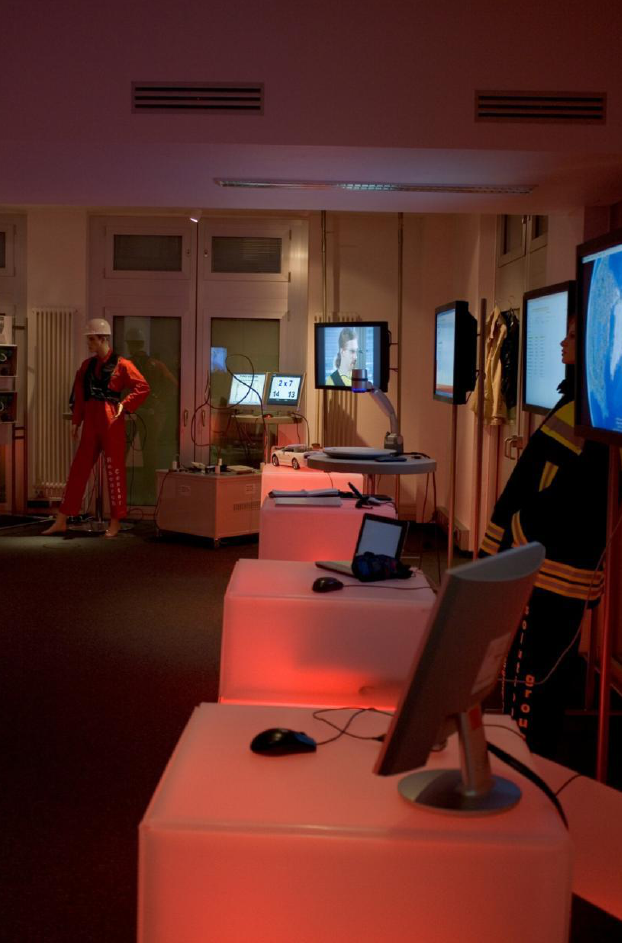
Fig. 2. Showroom for mobile technologies at the University of Bremen.